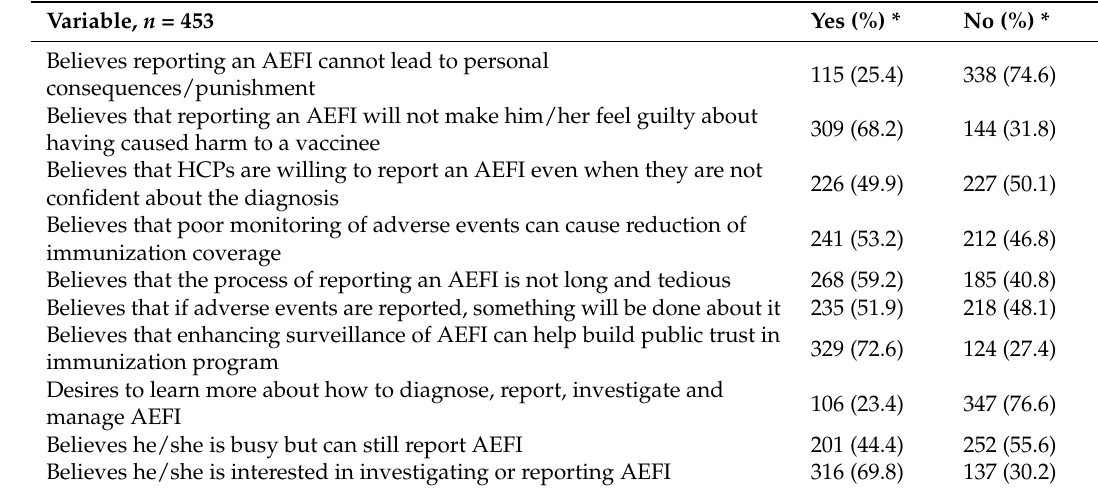
Table 4. Perceptions of AEFI among healthcare professionals.